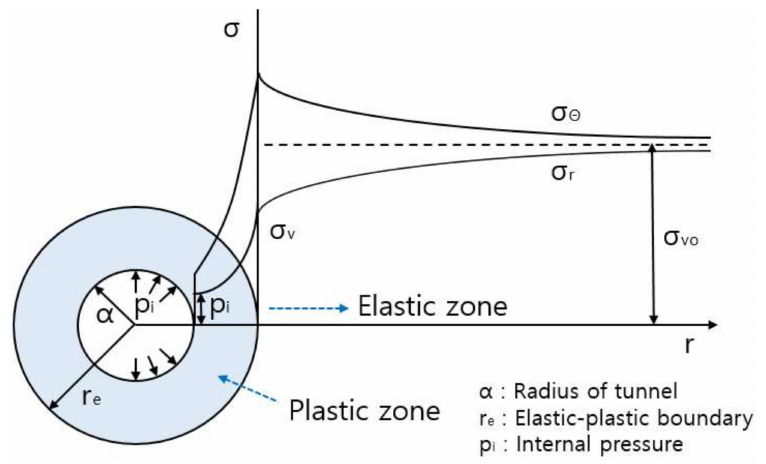
Figure 8. Definition of plastic zone.